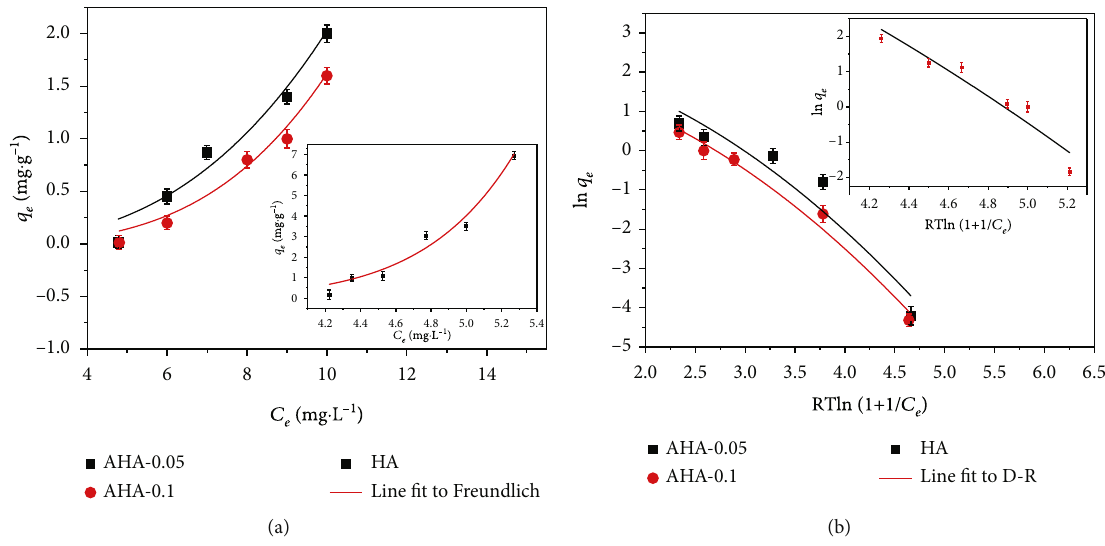
Figure 4: (a) Freundlich model fi tting the adsorption of TC on the AHA-0.05 and AHA-0.1 HA, and insert is the HA; (b) Dubinin- Radushkevich model fi tting the adsorption of TC on the AHA-0.05 and AHA-0.1, and insert is the HA. Table 2: Parameters of the isotherm models describing the sorption of